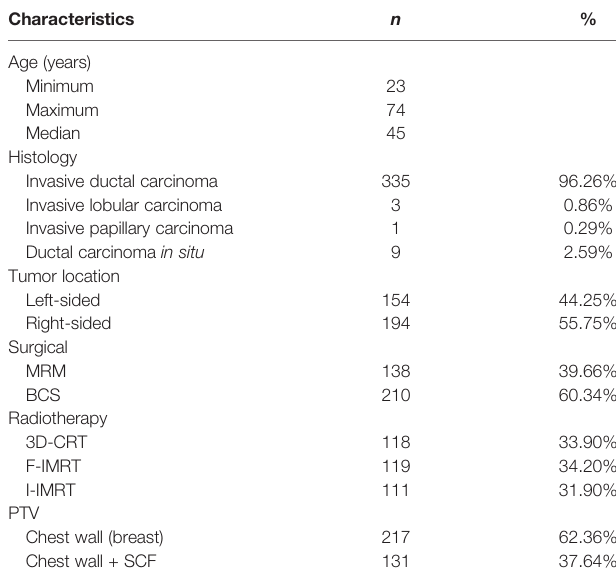
TABLE 1 | Patient characteristics and treatment